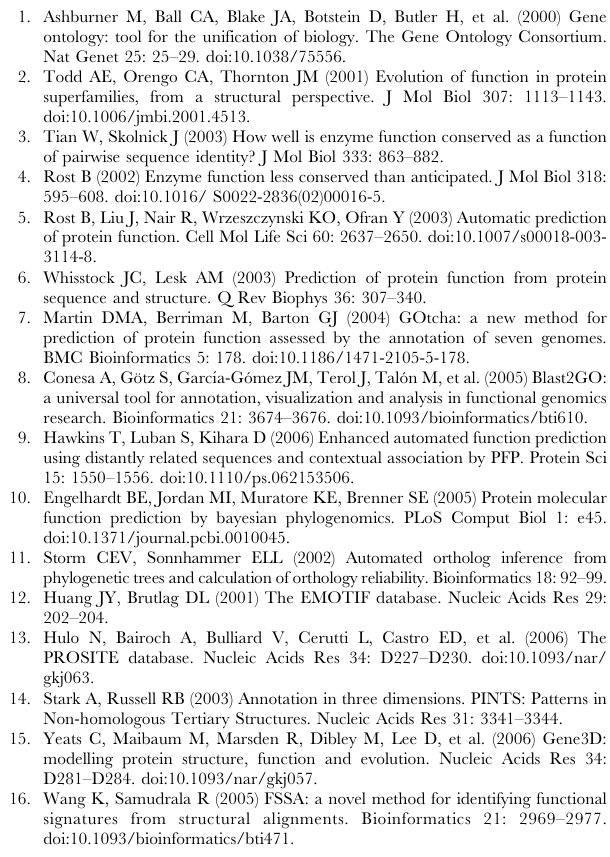
Figure S2 Assessing similarity based inference on the high- quality data set. We entirely repeated the estimates and calculations performed for the high-coverage data set in the main manuscript on a high-quality data set. This high-quality data set is restricted to annotations that stem traceably from literature (evidence code TAS) or from direct experiments (evidence codes IDA, IEP, IGI, IMP, IPI), leaving 945 proteins with curated experimental annotations. This figure corresponds to Figure 1 in the main paper, with the evaluation performed on high-quality